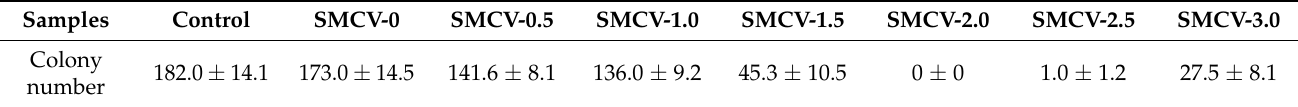
Table 2. The E. coli colony number on LB solid medium of